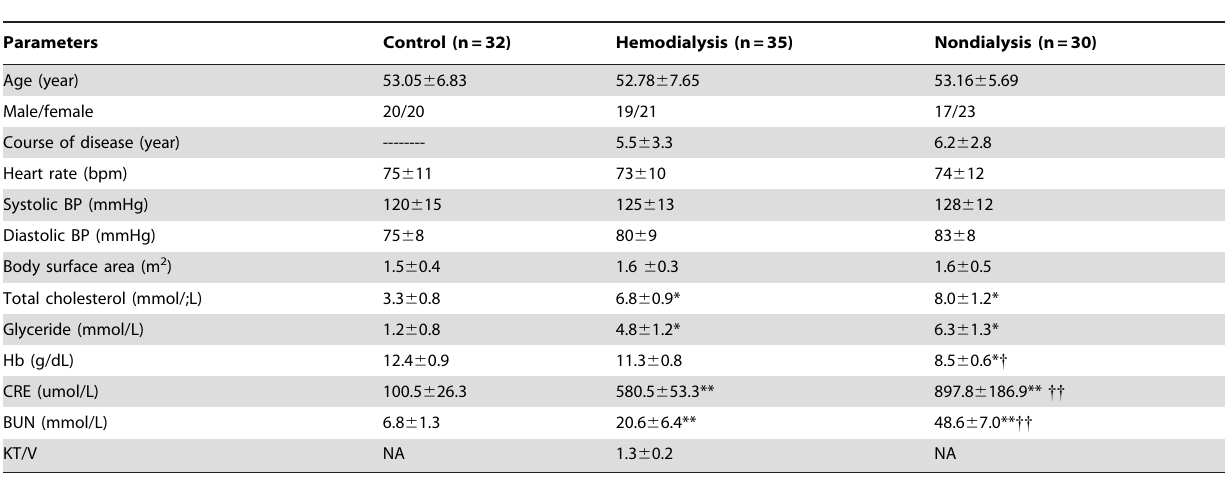
Table 1. Clinical Characteristics of the Uremia and Control